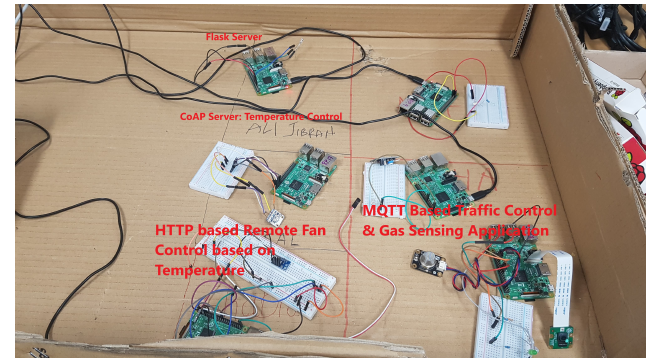
Figure 14. IoT testbed client experimental setup.